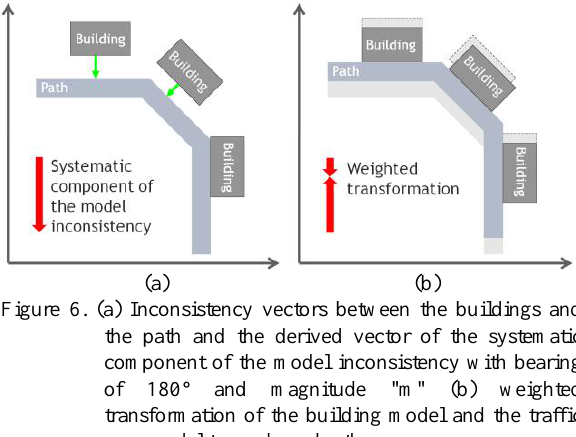
Figure 6. (a) Inconsistency vectors between the buildings and the path and the derived vector of the systematic component of the model inconsistency with bearing of 180° and magnitude "m" (b) weighted transformation of the building model and the